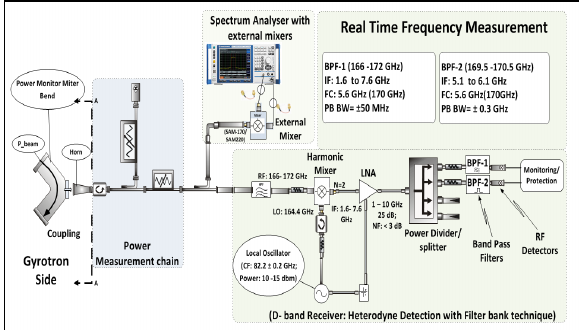
Fig. 20 : Gyrotron output RF beam Frequency measurement scheme